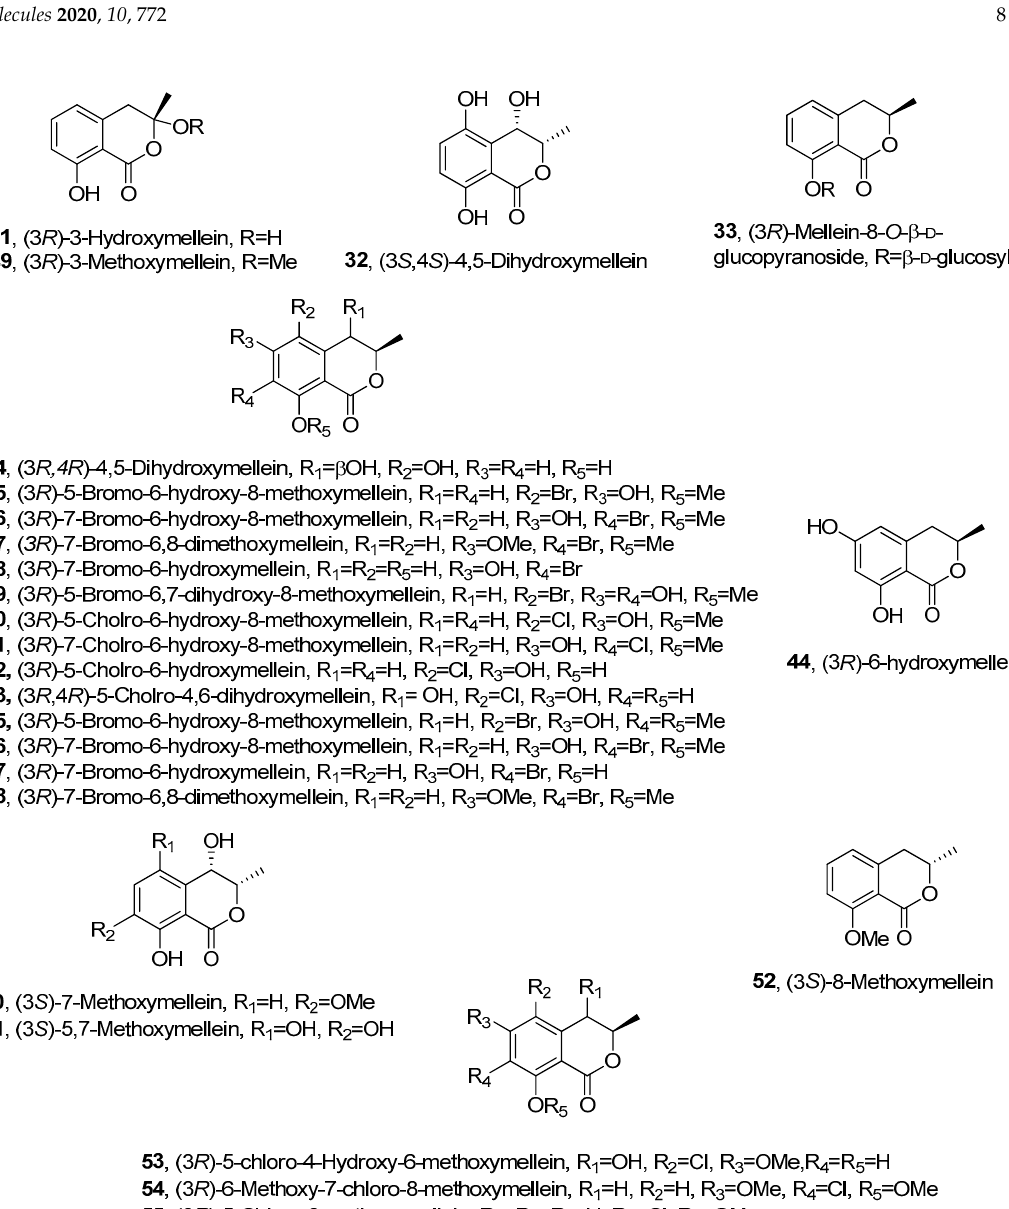
Figure 3. The structures of compounds 31 – 55 .